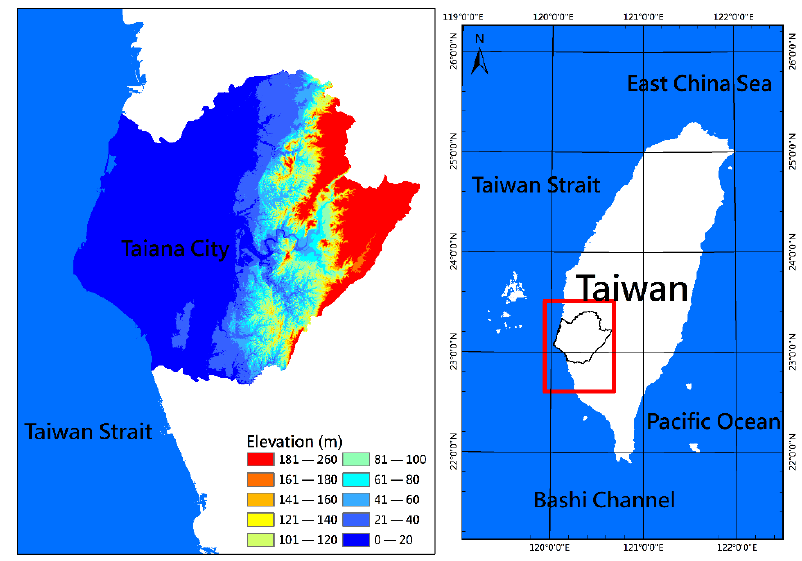
Figure 1. Map of the study area.